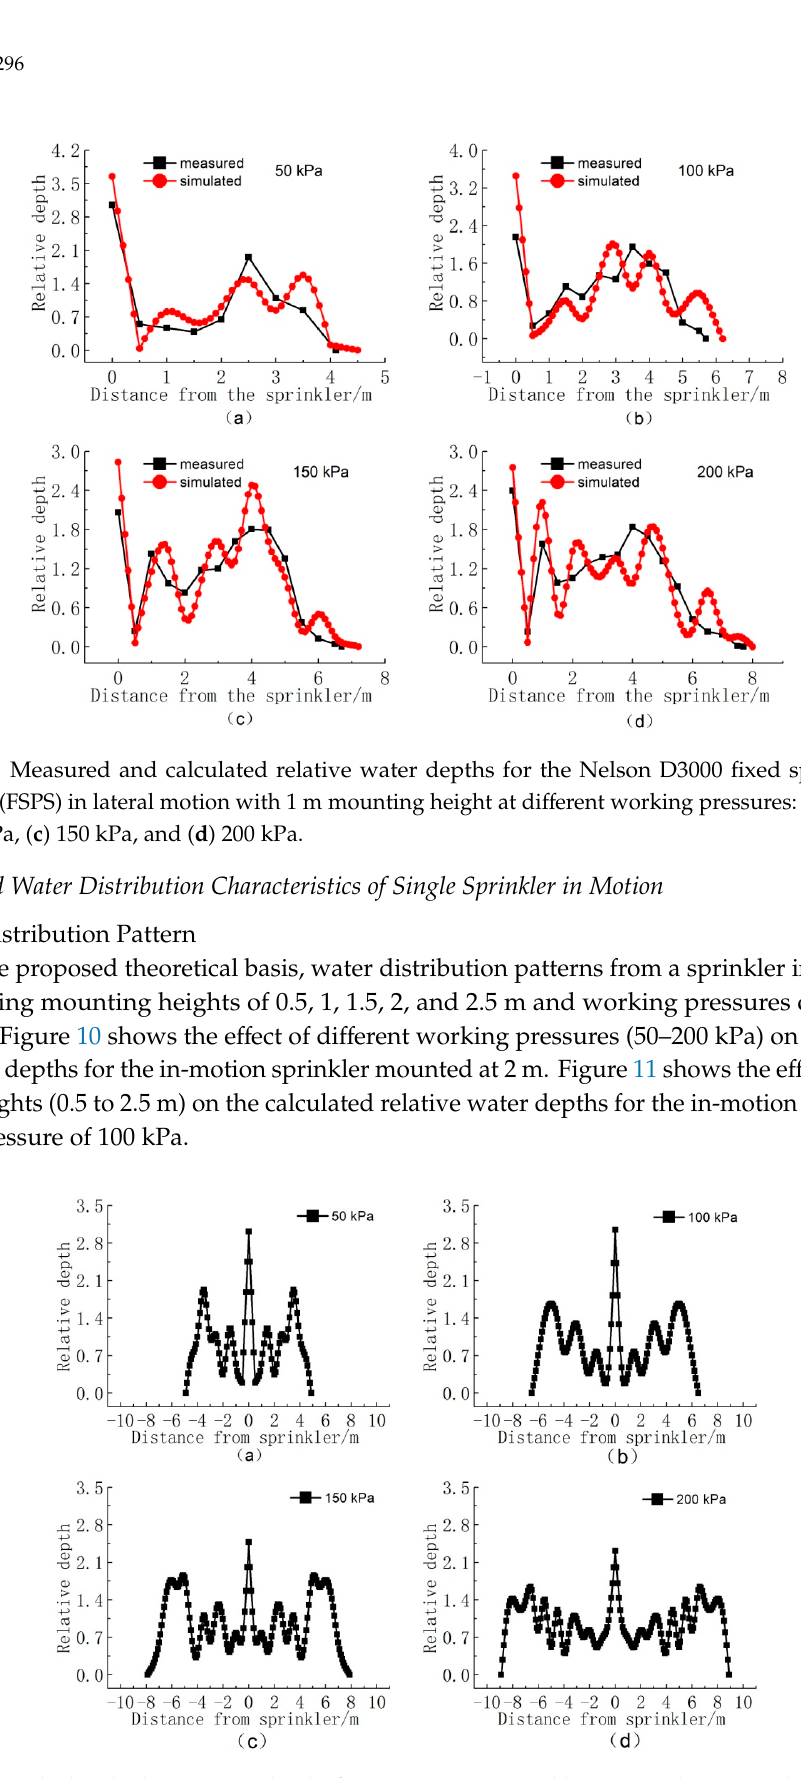
Figure 10. Calculated relative water depths for an in-motion sprinkler mounted at 2 m and at di ff erent working pressures: ( a ) 50 kPa, ( b ) 100 kPa, ( c ) 150 kPa, and ( d ) 200